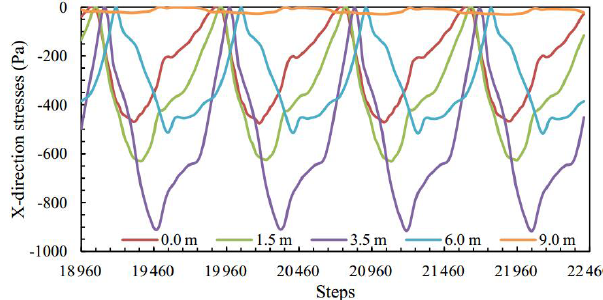
Figure 3. X -direction stresses at different distances from the central line of the tunnel.